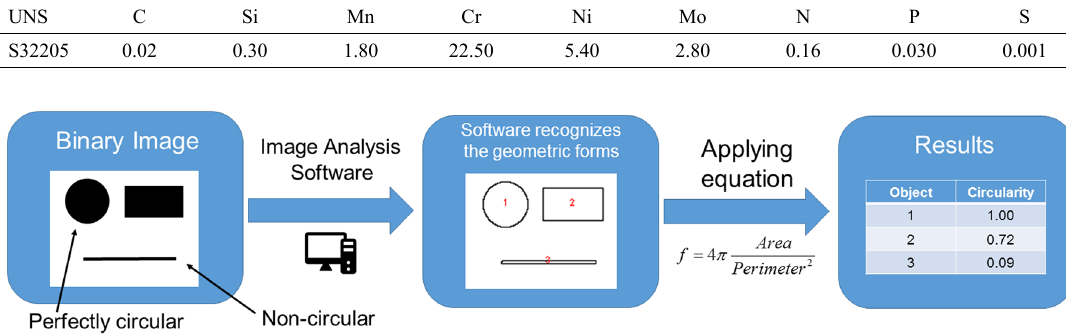
Figure 1. Schematic procedure for determination of